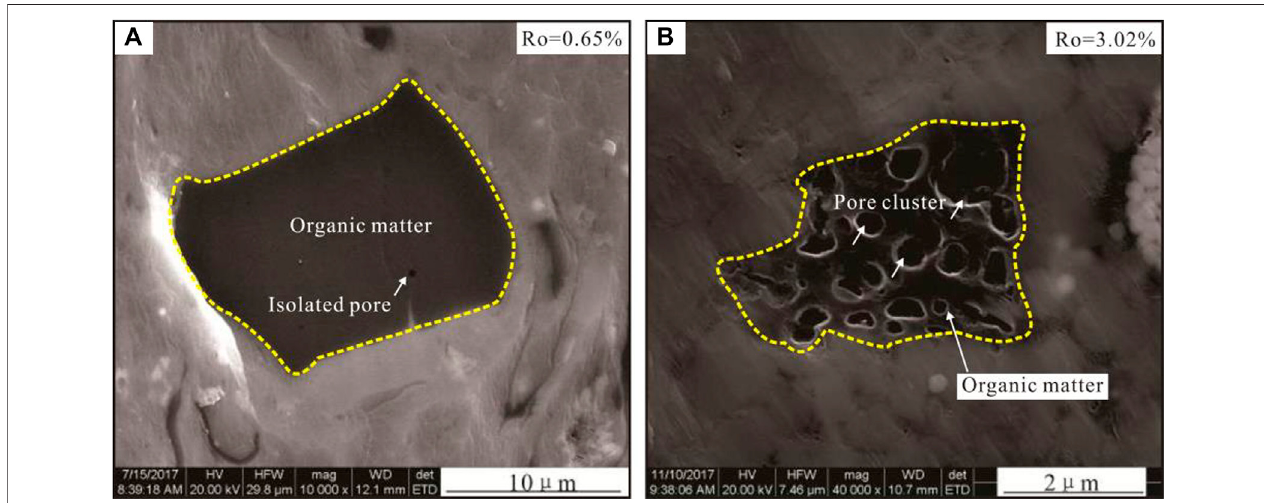
FIGURE 6 | Comparison of the development degree of shale organic matter pores under different thermal evolution degrees. Notes: (A) Well TP1-1, 1,586.2 m, R o (cid:2) 0.65%; (B) Well Lc-1, 2,477 m, R o (cid:2) 3.02%.